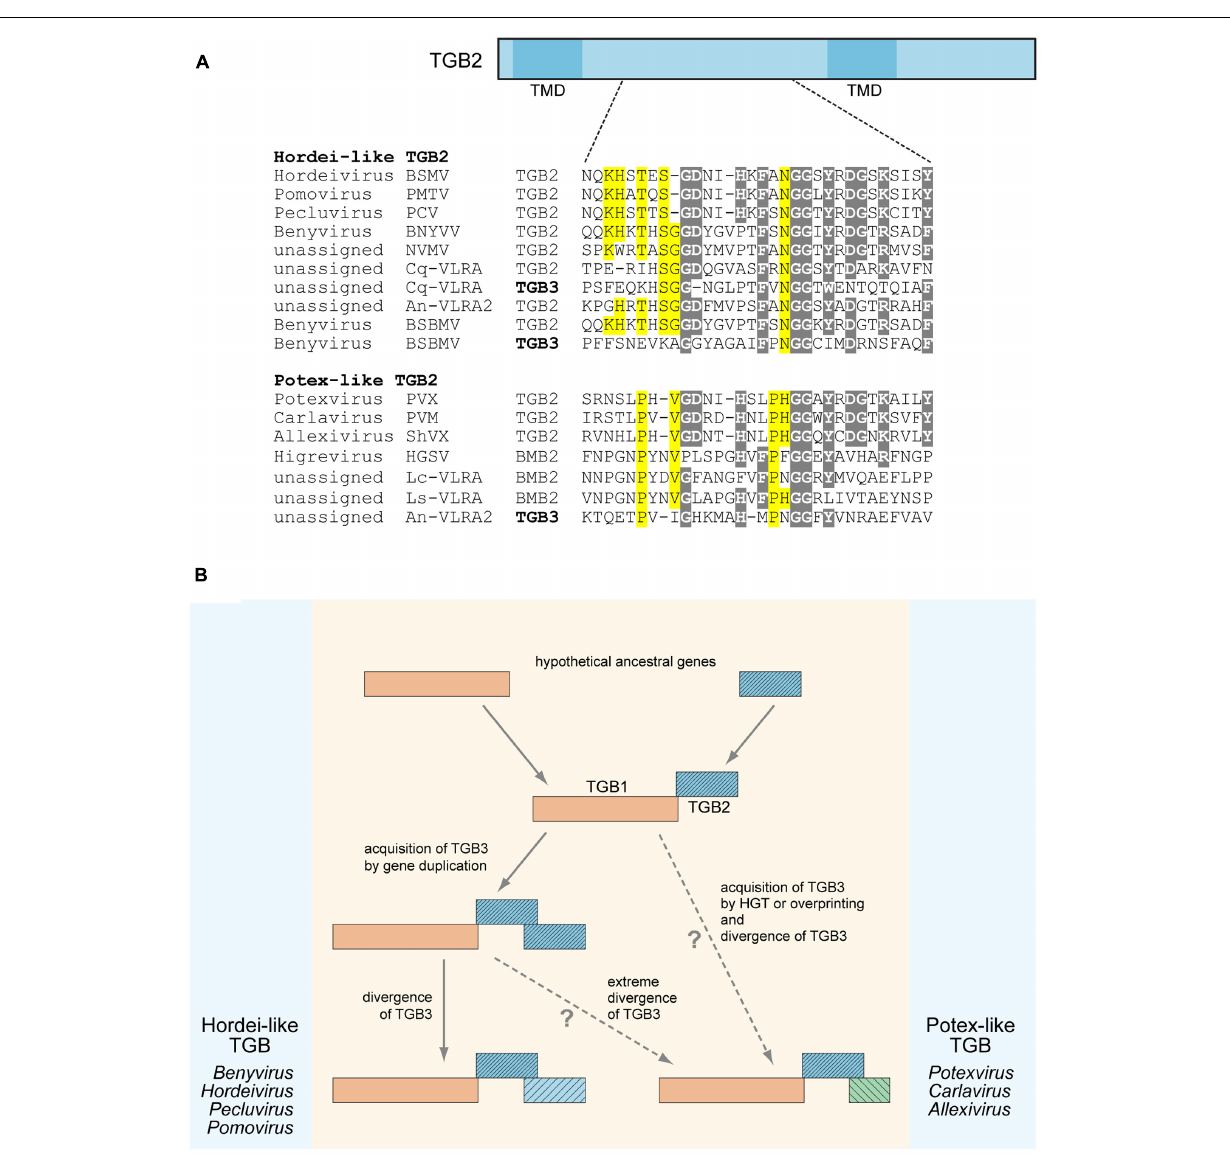
FIGURE 1 | Sequence conservation and possible evolutionary origin of TGB2 and TGB3 proteins. (A) Alignment of amino acid sequences located in the central conserved hydrophilic region between two transmembrane domains (TMD) of TGB2 proteins. TGB2 protein is schematically shown above the alignment as a box; the positions of TMDs are indicated; the position of aligned sequence region in TGB2 is shown by dashed lines. TGB3 sequences showing similarity to TGB2 sequences in the aligned region are included into the alignment and shown by bold. Alignments for hordei-like and potex-like TGB2 proteins are presented separately. Gray shading indicates residues conserved in both TGB types, yellow shading shows residues specifically conserved either in potex-like TGB2, or in hordei-like TGB2. BSMV, Barley stripe mosaic virus ; PSLV, PMTV, Potato mop-top virus ; BSBV, Beet soil-borne virus ; PCV, Peanut clump virus ; BNYVV, Beet necrotic yellow vein virus ; NVMV, Nicotiana velutina mosaic virus ; BSBMV, Beet soil-borne mosaic virus ; PVX, Potato virus X ; PVM, Potato virus M ; ShVX, Shallot virus X ; HGSV, Hibiscus green spot virus ; CqVLRA, Colobanthus quitensis contig 125488 (NCBI accession GCIB01126289); An-VLRA2, Asplenium nidus assembly (1KP database accession PSKY-2058768); Lc-VLRA, Litchi chinensis assembly (1KP database accession WAXR-2010981); Ls-VLRA, Lathyrus sativus (NCBI accession GBSS01016353). (B) Proposed general scheme of TGB evolution. Processes specific for potex-like and hordei-like TGBs are shown on the right and left,